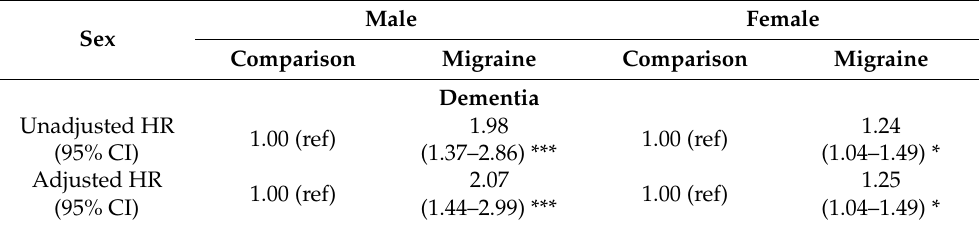
Table 3. Hazard ratios of dementia by sex among the sample patient.